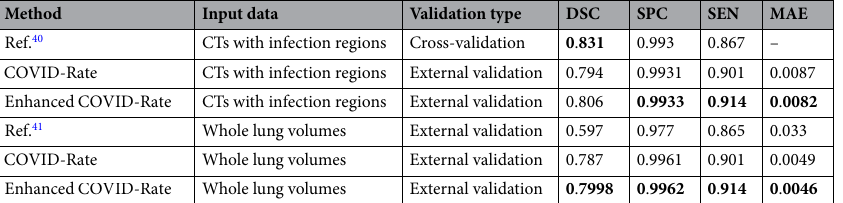
Table 5. Model evaluation on external dataset on CT images containing COVID-19 lesions and on whole CT volumes. Significant values are in bold.